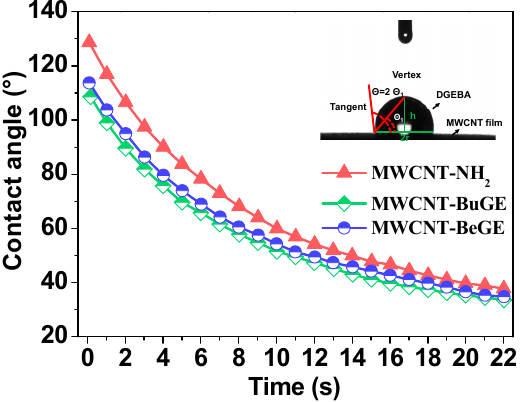
Figure 8. Dynamic contact angle of DGEBA on MWCNT-NH 2 , MWCNT-BuGE and MWCNT-BeGE films varies with time at room temperature (Inset image is the contact angle measurement process with side view of DGEBA on the MWCNT film).